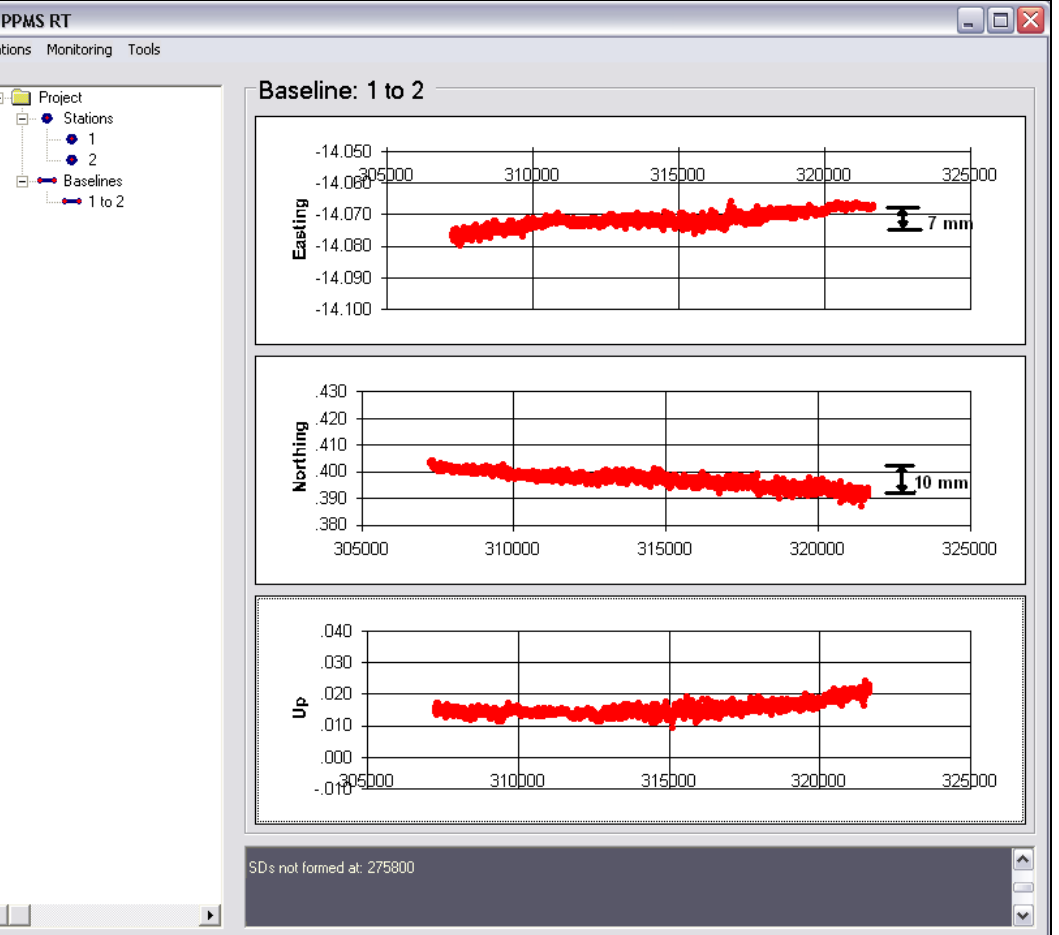
Figure 14. PPMS Graphical Display of Target